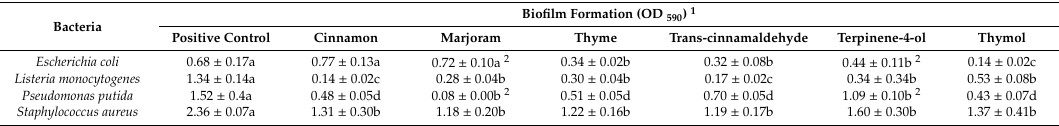
Table 2. E ff ect of essential oils and components (in MIC / 2 concentration) on monoculture biofilm formation of food-related